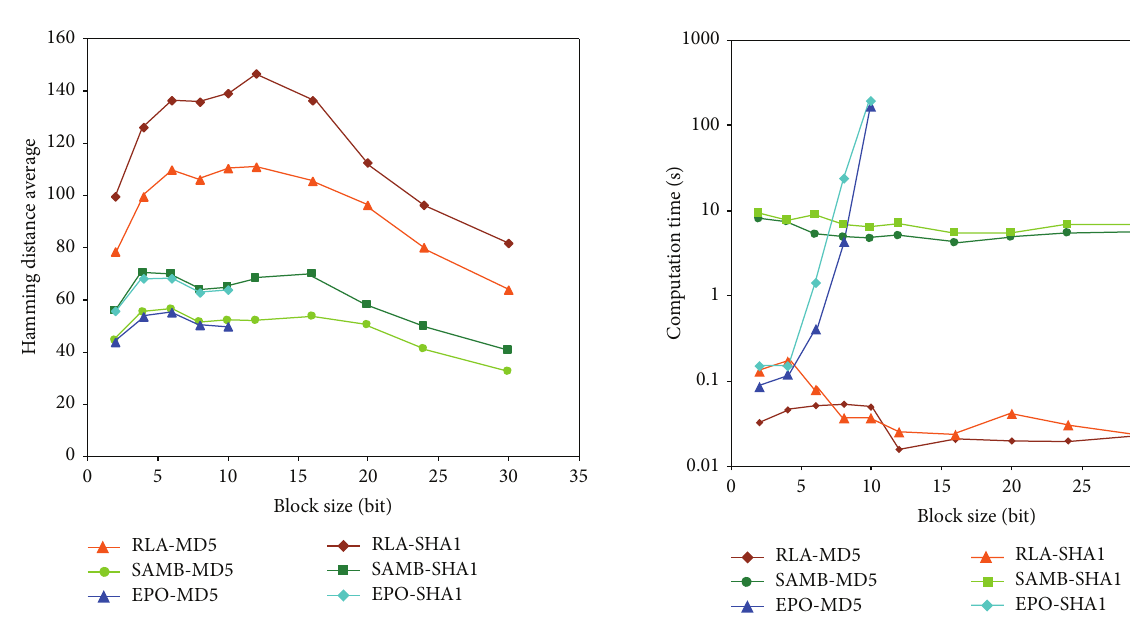
the algorithms in terms of computation time and HAD is made.